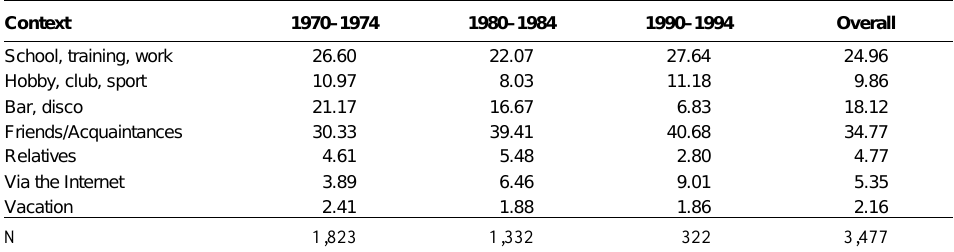
Ways of finding a partner by birth cohort in different contexts (column-wise